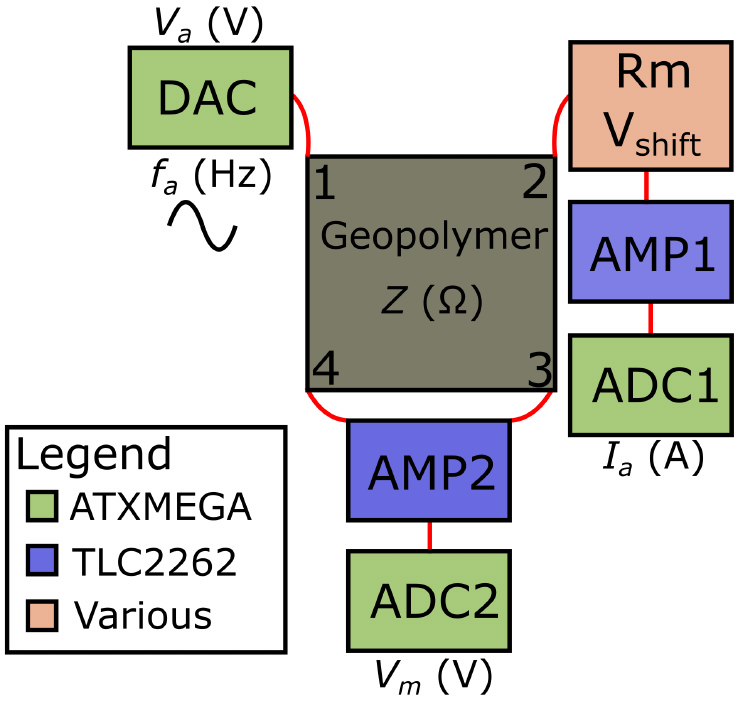
Figure 3. Simplified block diagram of ConcrEITS: a DAC from the MCU is used to apply an AC voltage, V a , of varying frequency, f a , which results in the applied current, I a , over the excitation elec- trodes 1 and 2. A voltage is measured over opposing electrodes 3 and 4, V m , to give the impedance of the AAM, Z . Voltage measurements are taken using the MCUs ADCs following suitable amplification by a